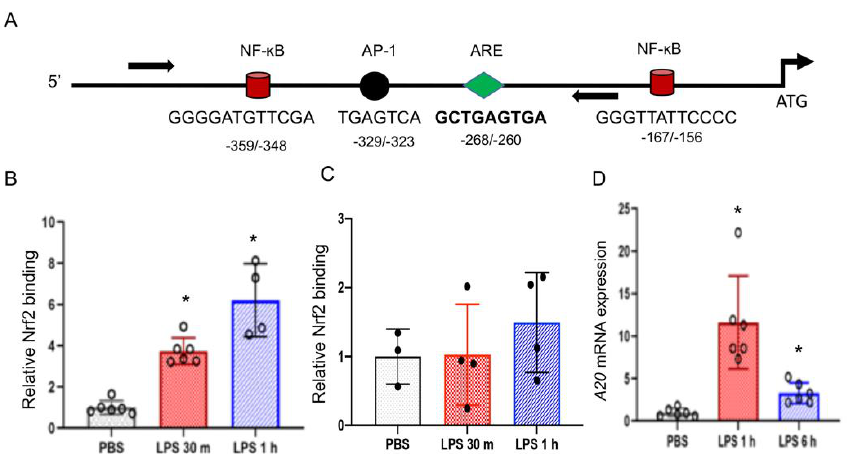
Figure 6. Nrf2 binding at the A20 promoter in LPS treated BMDM Φ s and LDM Φ s. ( A ) Schema represents position of the antioxidant response element (ARE), and NF- κ B and AP-1 binding sites of the murine A20 promoter. BMDMs ( B ) and MH-S cells ( C ) were treated with PBS or LPS (100 ng/mL) for 30 or 60 min, crosslinked and ChIP assays were performed using Nrf2 antibodies and murine A20 promoter specific forward and reverse primers (arrows) flanking the ARE. The relative Nrf2 binding was calculated using PBS control samples values as one arbitrary unit. ( D ) MH-S cells treated with LPS (100 ng/mL) for 1 h or 6 h. RNA isolated and A20 mRNA expression was ana-lyzed. * versus